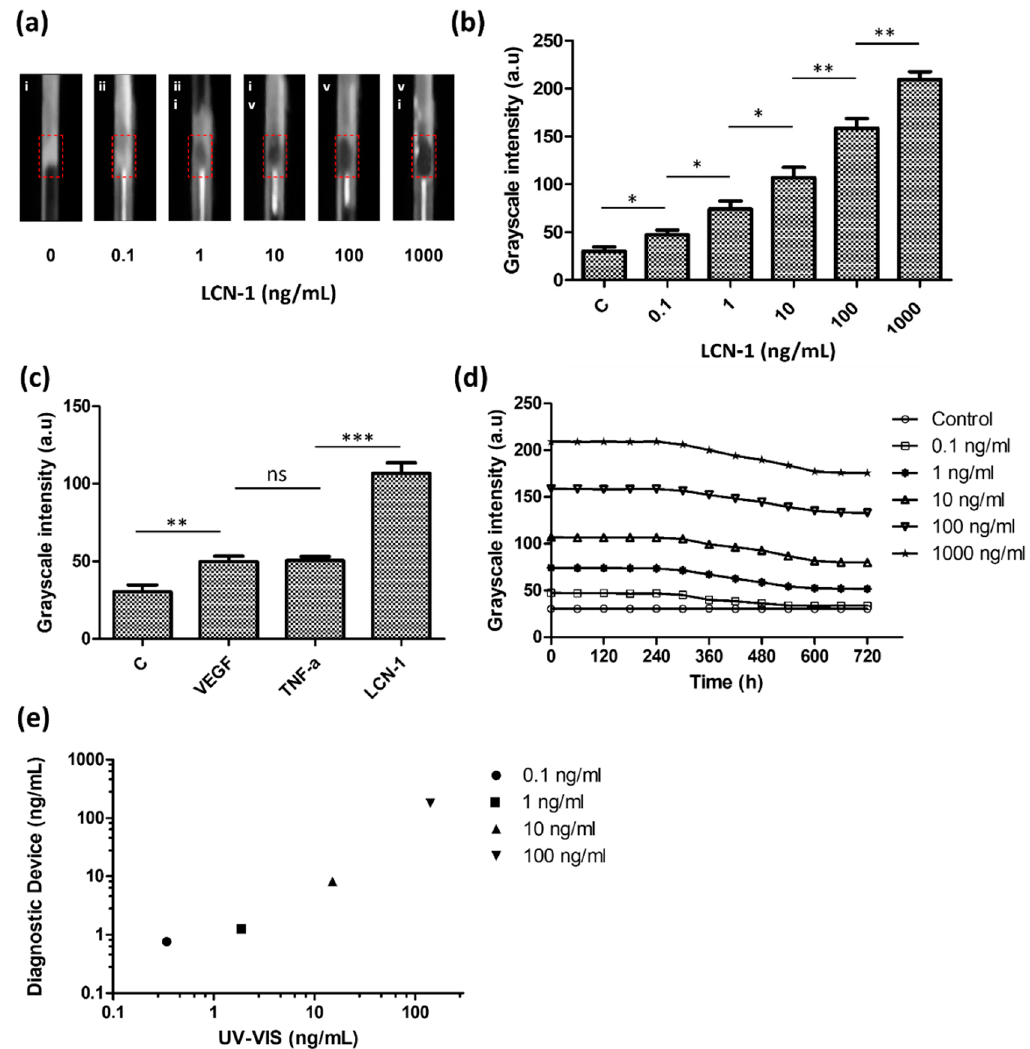
Figure 7. Quantitative assessment of the detection platform: ( a ) grayscale images of diagnostic tool inside the detection box; ( b ) calibration of the grayscale intensity of sandwiched immunocomplex with respect to different lipocalin-1 (LCN-1) concentrations ranging from 100 pg/mL to 1 µg/mL; ( c ) binding specificity of the capture and probe particles in the presence of different antigens; ( d ) binding stability of sandwiched immunocomplex with respect to different times; ( e ) reliability of the detection platform. Comparison of LCN-1 concentration detection results between the proposed diagnostic tool and spectrophotometer. The symbols “*”, “**”, “***”, “ns” denote p < 0.05, p < 0.01, p < 0.001, and p > 0.05, respectively, under student’s t test ( n = 5). The error bars represent standard deviation.